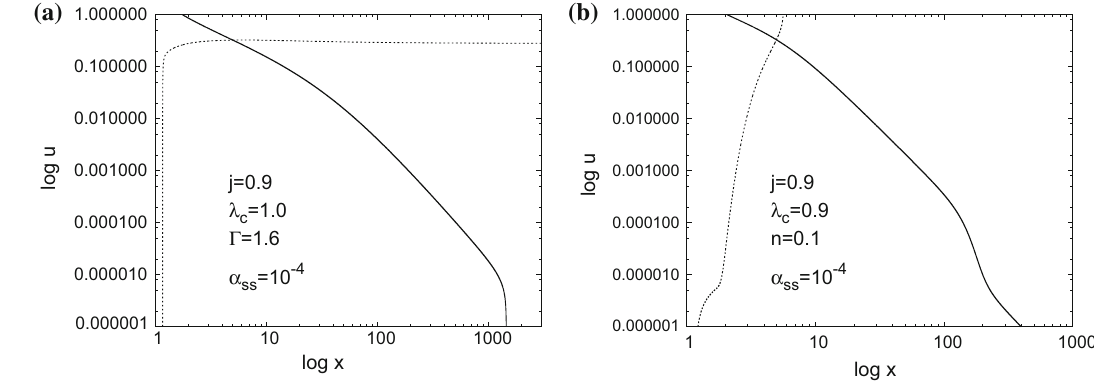
Fig. 8 a , b are plots of log( u ) vs. log ( x ) for viscous ( α ss = 10 − 4 ) accretion disc flow around a rotating BH (with specific angular velocity j = 0 . 9) for adiabatic and MCG cases, respectively. Accretion and wind curves are depicted by solid and dotted lines, respectively